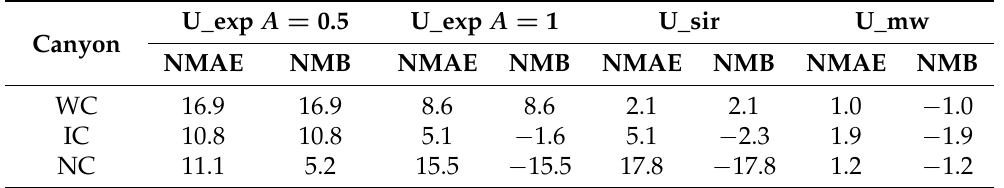
Figure 5. Comparison of Ustreet normalized by U H , ϕ between Code_Saturne and the different MUNICH parametrizations for ( a ) WC, ( b ) IC and ( c ) NC and depending on ϕ . Table 4. Normalized Mean Absolute Error (NMAE) and Bias (NMB) (%) between Code_Saturne and MUNICH parametrized U street for the three canyons studied and for all ϕ ( n =